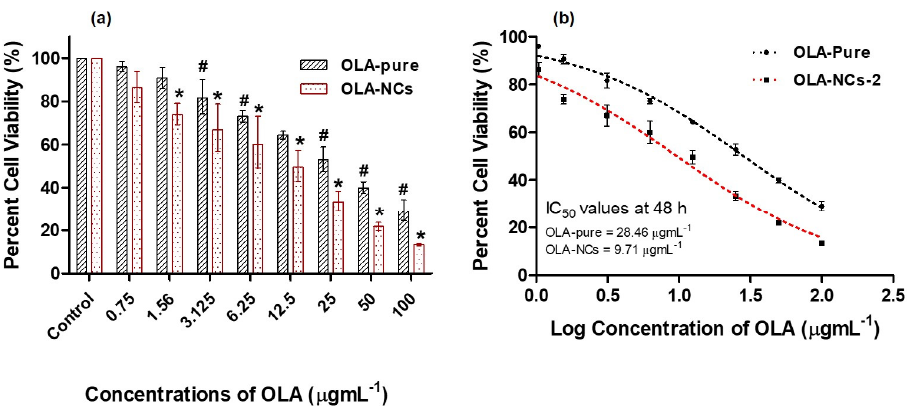
Figure 8. The cell viability assays of OLA-pure and OLA-NCs by considering the 100% cell viability in the control group. Data were presented as mean of three readings with standard deviations (Mean ± SD, n = 3). * p < 0.05 designates the significant difference between OLA-NCs vs. OLA-pure (except at 0.75 µg·mL − 1 ) and the control (untreated cells) while # p < 0.05 designates the significant difference between OLA-pure vs. the control (untreated cells) ( a ). The cytotoxicities for OLA-pure and OLA- NCs with their IC 50 values (µg·mL − 1 ) after 48 h of incubation with MCF-7 cells ( b ).